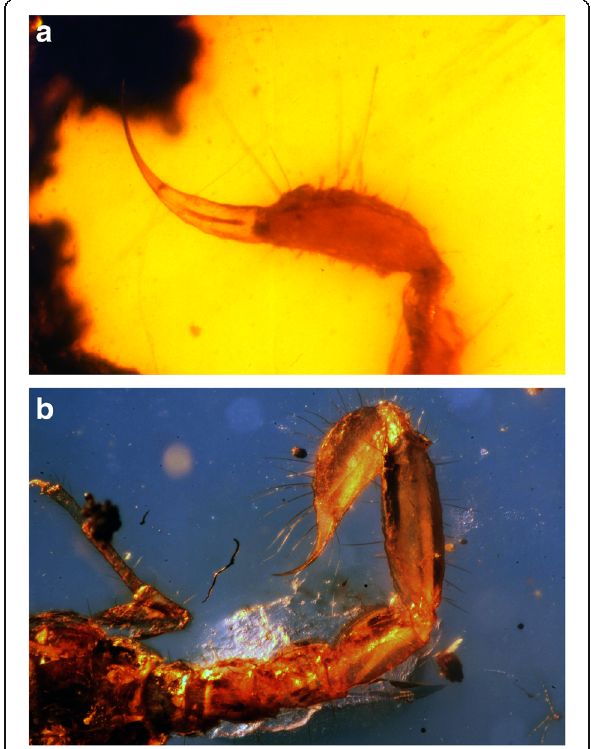
Fig. 6 Telsons of two Early Cretaceous amber fossils from Burma, Myanmar. a Palaeoburmesebuthus grimaldi Lourenço (Palaeoburmesebuthidae). b Chaerilobuthus schwarzi Lourenço (Chaerilobuthidae) ( b copyright by J. Velten, reproduced with